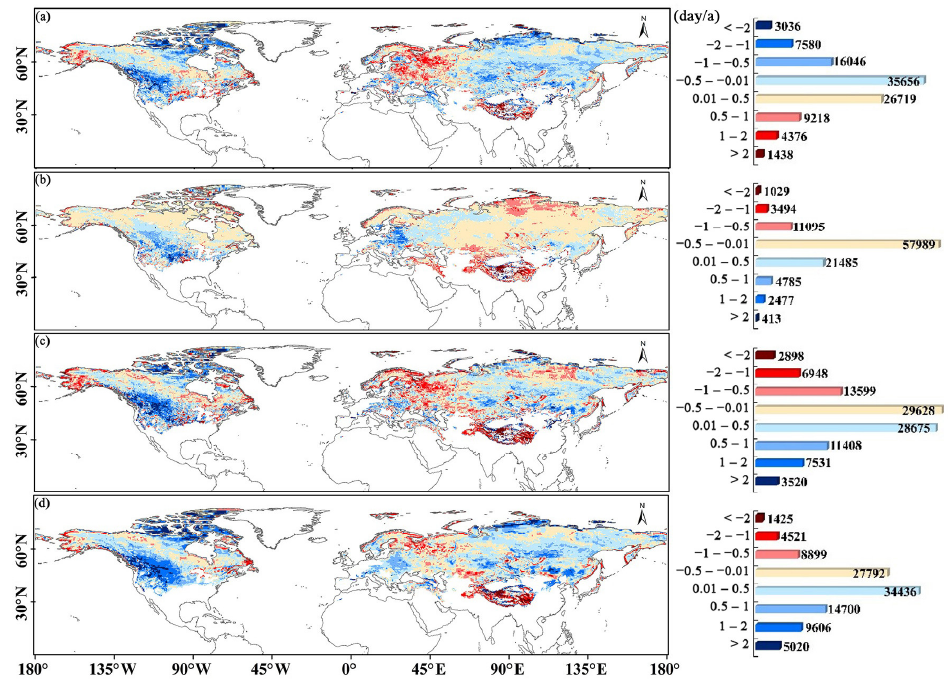
Figure 7. Variation slopes of the annual ( a ) SCOD, ( b ) SCED, ( c ) SSL, and ( d ) SCD in the NH. The histograms on the right correspond to the ( a ) SCOD, ( b ) SCED, ( c ) SSL, and ( d ) SCD legends. Across the NH, the SCED was delayed significantly in the central and southern Rockies of North America, with delays of one–two days per year recorded in some fragmented areas. This trend was also observed in Western Europe and northeast China, but the delay rates were smaller than those observed in the former region. In contrast, in most of the West Siberian Plain and the Central Siberian Plateau, the SCED showed significant advancing trends, especially in the Arctic region, where the SCED advanced by 0.5 to 1 days/a.